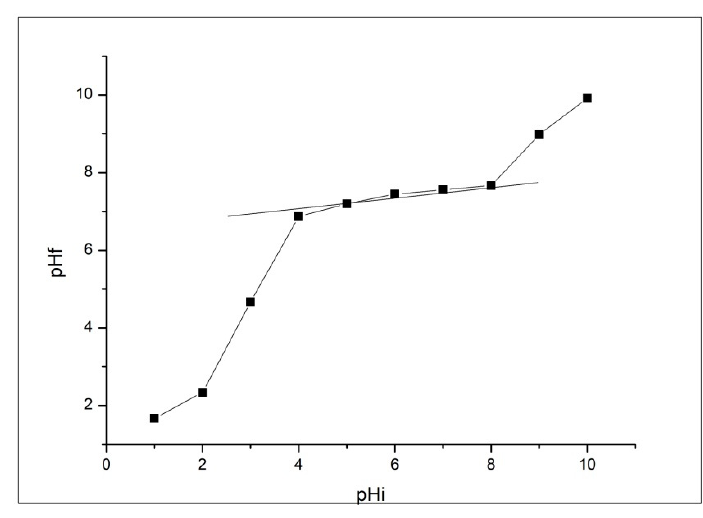
Figure 7. The pH PZC of the magnetic nanocomposite MNPs35@SiO 2 .